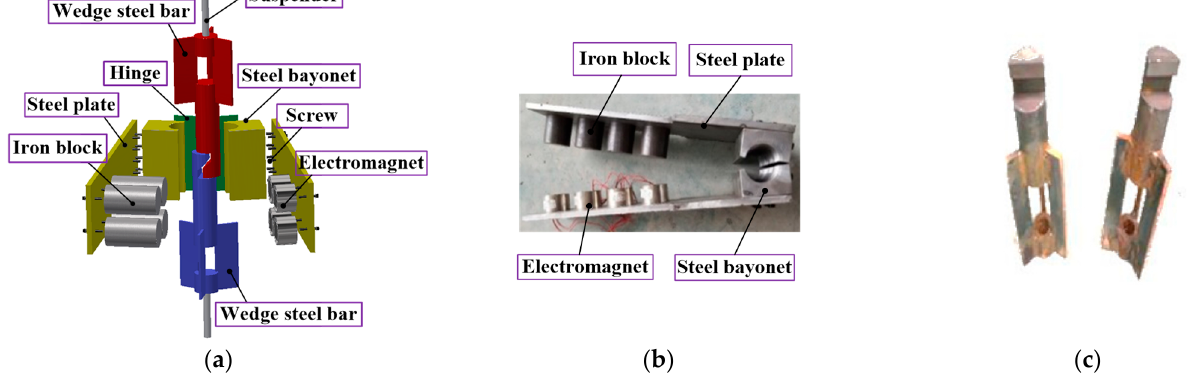
Figure 5. The suspender rupture trigger device: ( a ) general view of the installation; ( b ) magnetic fluxer clamps; ( c ) wedge steel bar.